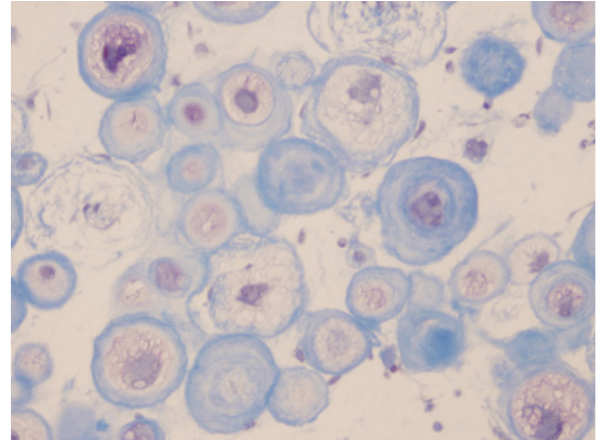
Fig. 7. Detail of target-like chondrocytes in Masson’s staining method demonstrating the presence of collagen, x200.